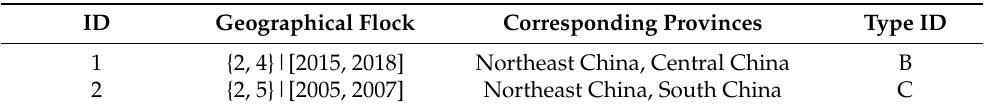
Table 5. The discovered geographical flock patterns based on the criterion of the high–low attribute values on the geographical region level.